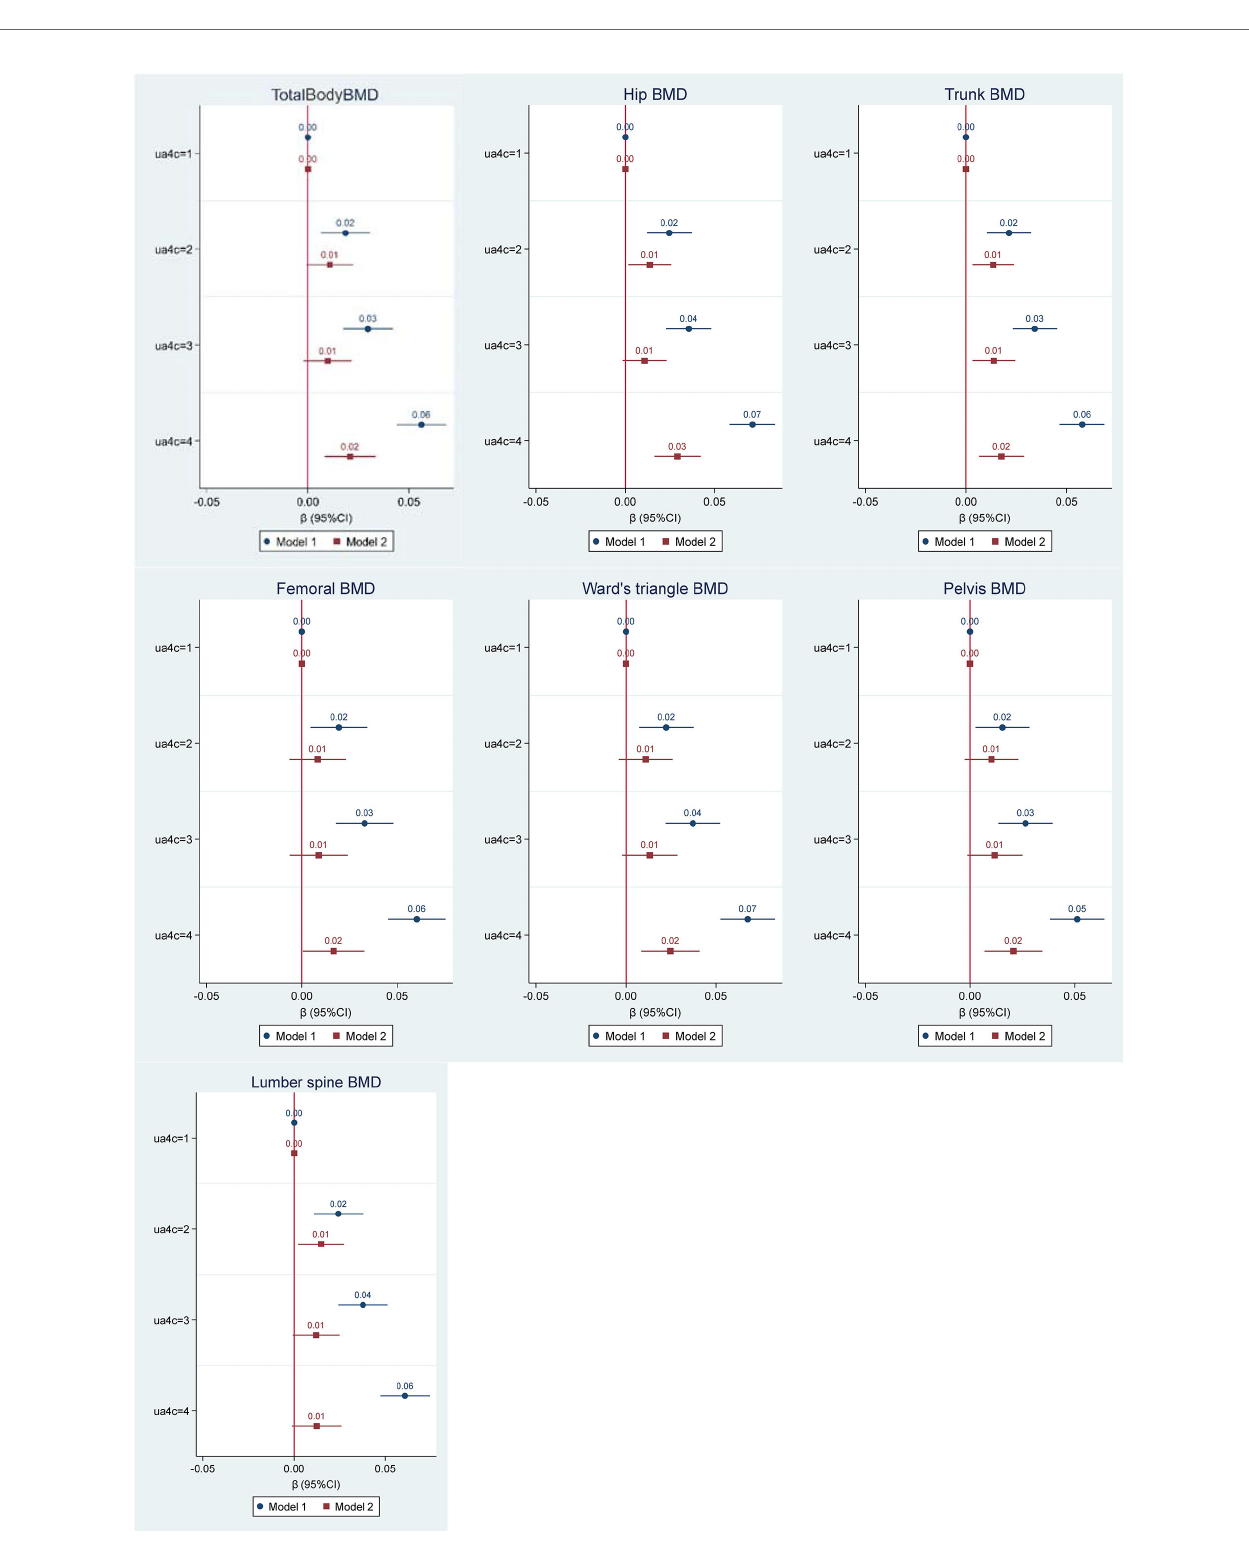
FIGURE 2 | Multiple regression analysis of the association between quartiles of serum uric acid (µmol/L) and bone mineral density (BMD) for total body and multiple skeletal locations (g/cm 2 ). Values represent the regression coef fi cients per SD change of uric acid. Model 1 adjusted for age and gender. Model 2 adjusted for age, gender, BMI, serum vitamin D, Alkaline Phosphatase, eGFR, and smoking status.